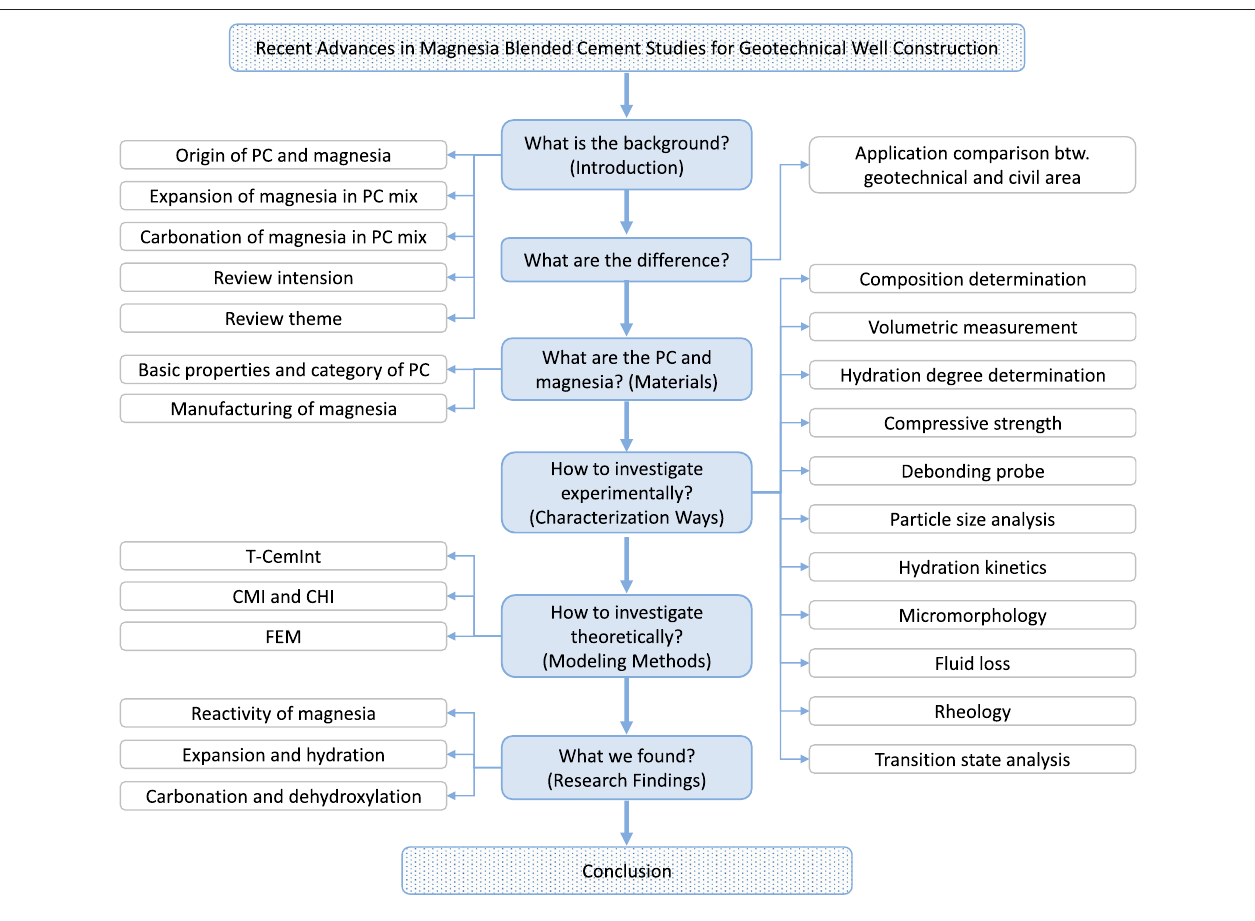
FIGURE 1 | Review structure